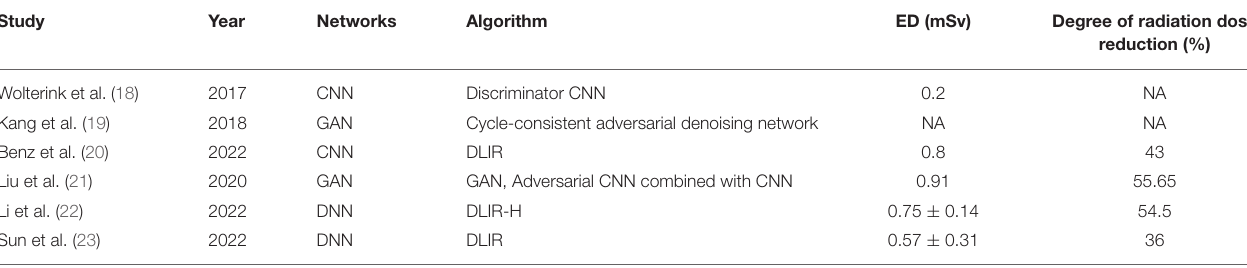
TABLE 1 | Application of artificial intelligence to reduce the radiation dose of CCTA.